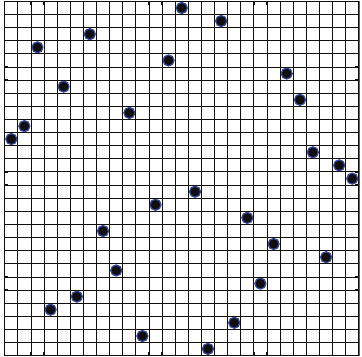
Figure 1: An example of a Costas array of order 27: note the haphazard positioning of its